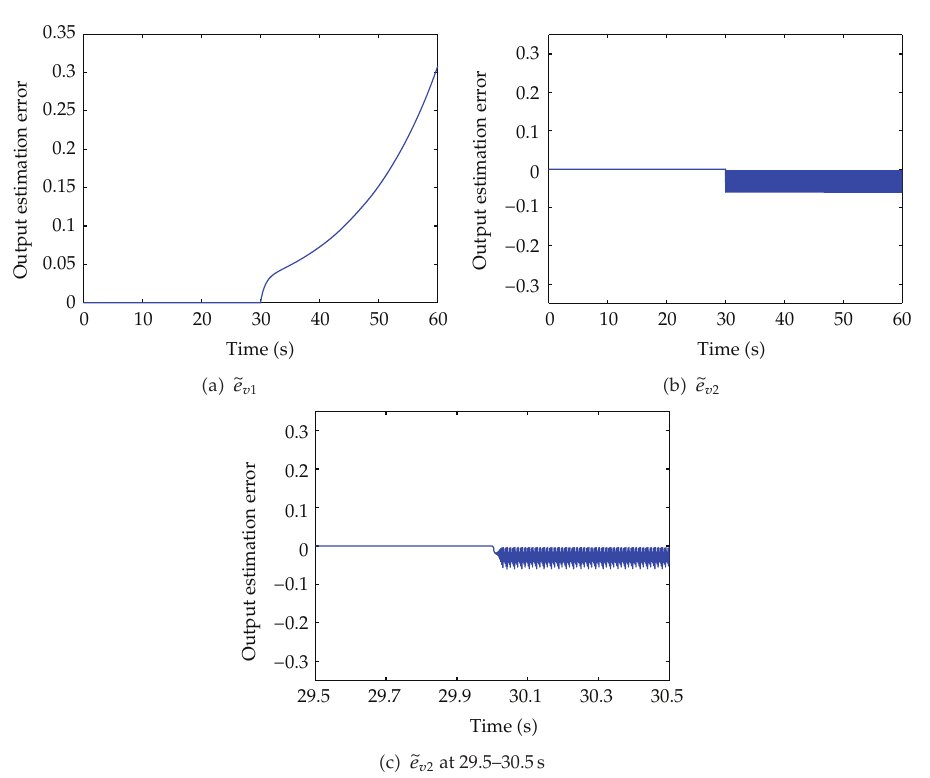
Figure 1: Output estimation error in case 1 using a high frequency